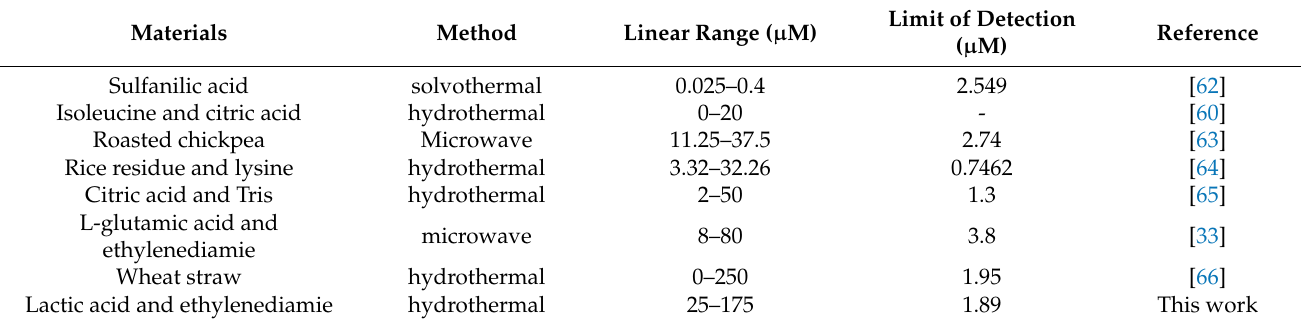
Table 2. Comparison on CQDs for determination of Fe 3+